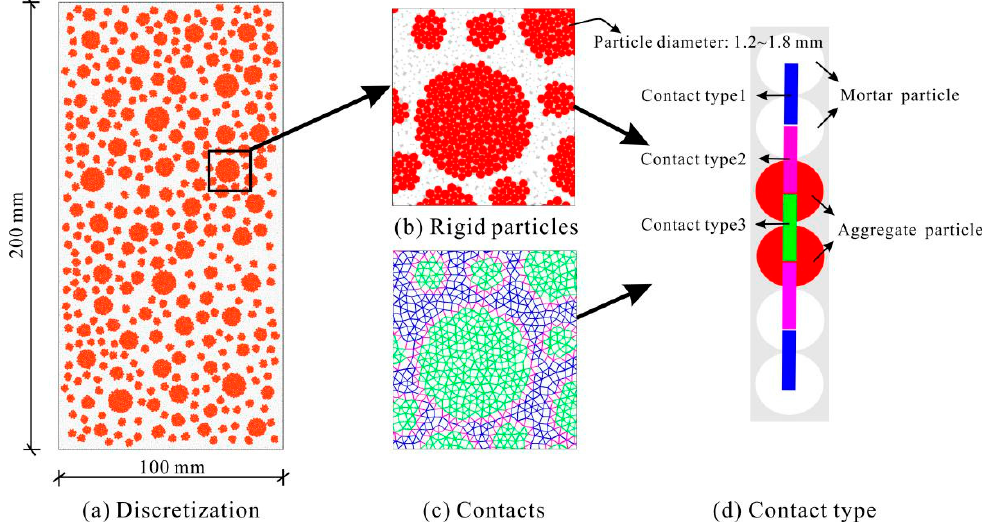
Figure 3. Discrete element modeling of ordinary concrete.